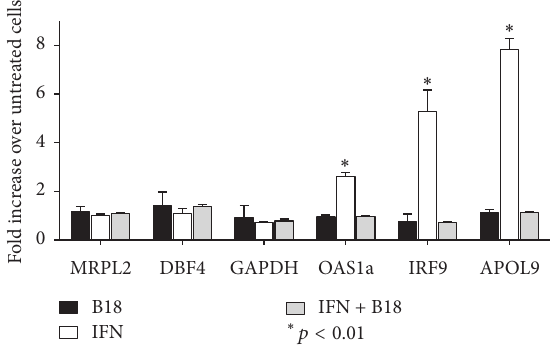
Figure 2: Confirmation of RNA-seq data by RT-qPCR after IFN induction. Gene expression for the indicated genes was assessed by RT-qPCR from L929 cells after incubation with B18, 50 units/ml IFN 𝛼 ,orIFNtogetherwithB18. 𝛽 -Actingenewasusedasareference to normalize the data. Expression values are shown as fold change comparedtountreatedcells(mean ± SEMandsignificantdifferences are